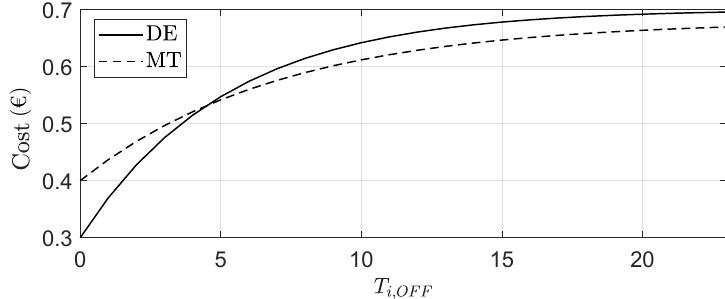
Figure 4. Cost of operation of the DE and MT in terms of the power supply.